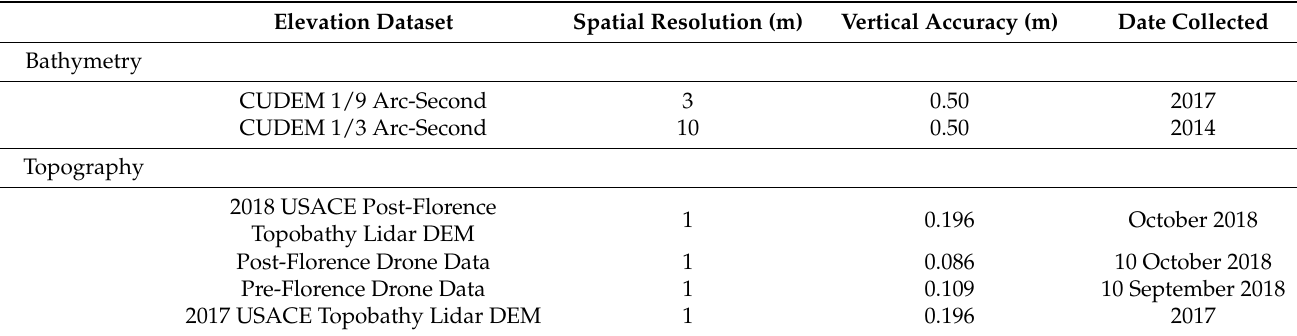
Table 1. Elevation datasets used for the model domain and statistical analyses. The month and year or just the year are reported for the date collected if a specific date was unavailable for an elevation